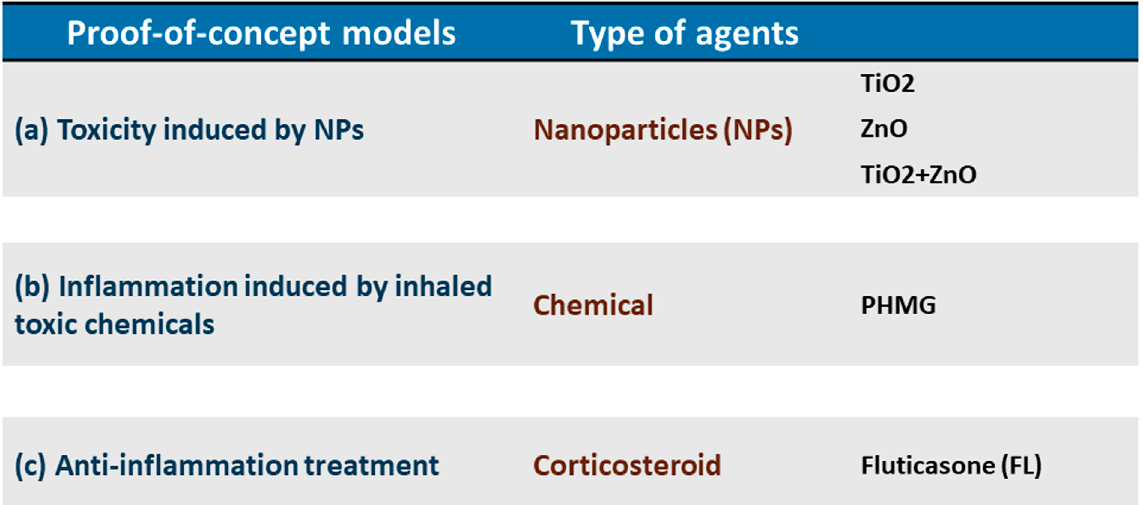
TABLE 1 Choice of environment-related substances used in the